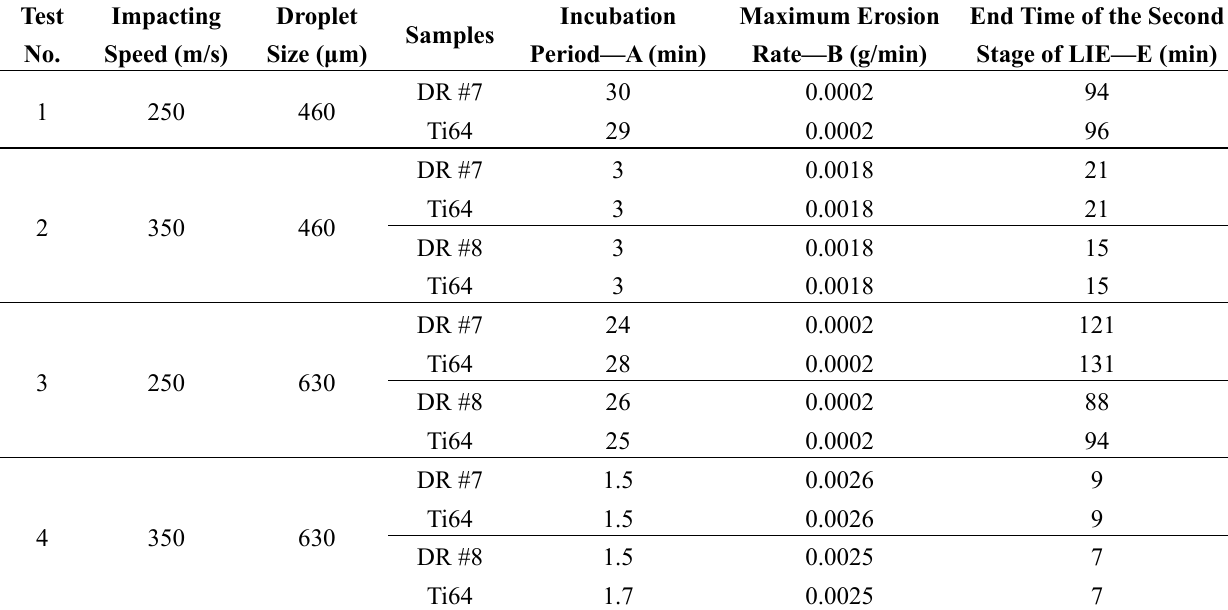
Figure 10. Maximum erosion rate determination methods, where, A is the nominal incubation period; B is the slope representing maximum erosion rate; C is the y -axis intercept of terminal erosion rate line; D represents the terminal erosion rate [4]; E is the end time of stage 2. Table 4. The combination of LIE test parameters and experimental results of the LIE curve